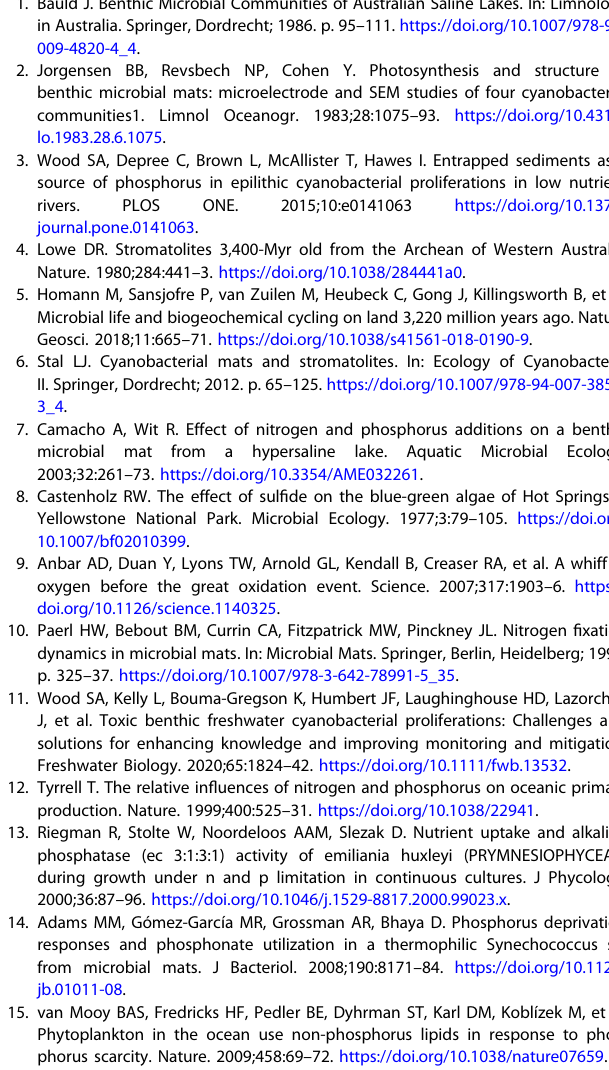
Fig. 4b: Phase 1). Yet, we are unaware of any polyP distribution study in multicellular or mat-forming cyanobacteria and hence, further mechanisms of interactions, e.g., cell-to-cell communica- tion [49, 50], might also contribute to purposeful differentiation of cells or fi laments within a common